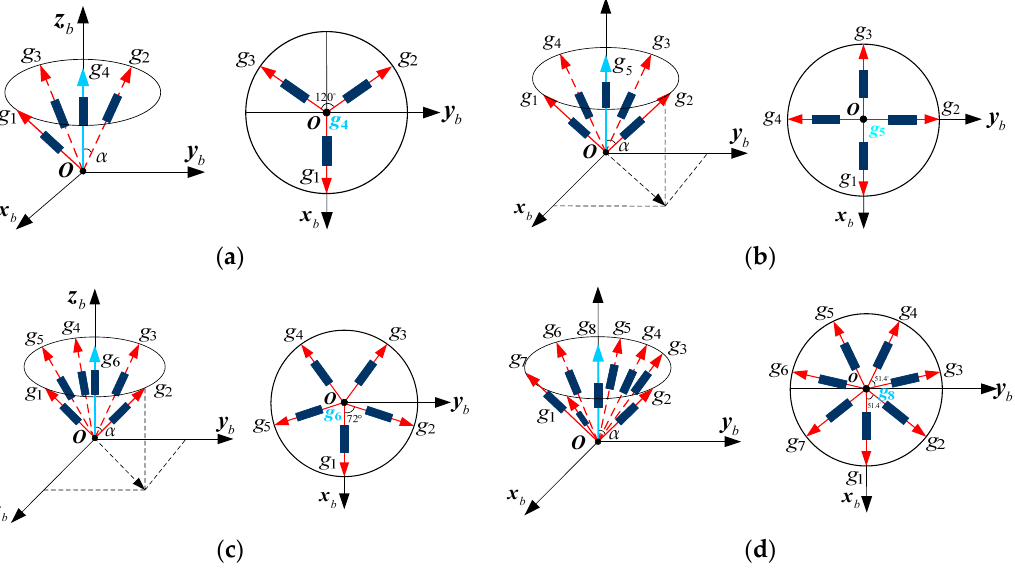
Figure 7. Non-orthogonal gyro array for the MIMU with a one-axis conical sensor: ( a ) 4-gyro cone; ( b ) 5-gyro cone; ( c ) 6-gyro cone; ( d ) 8-gyro cone.